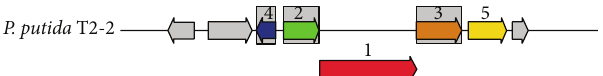
Figure 3: Genes organization of multidrug resistance efflux pumps identified by RAST annotation of T2-2 genome. (1) RND efflux system, inner membrane transporter, CmeB; (2) membrane fusion protein of RND family multidrug efflux pump; (3) RND efflux system, outer membrane lipoprotein, CmeC; (4) transcription repressor of multidrug efflux pump acrAB operon, TetR(AcR)